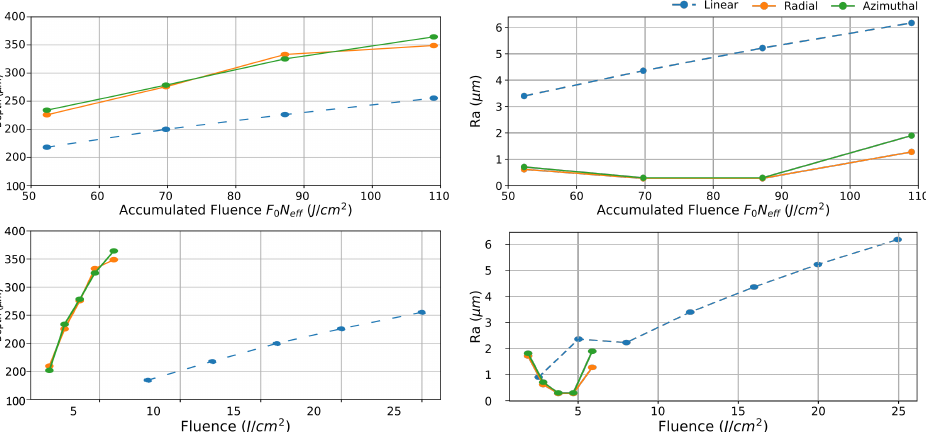
Figure 4. Depth ( right ) and arithmetic roughness ( left ) against accumulated fluence ( top ) and regular fluence ( bottom ) for linear Gaussian and CV in stainless-steel. CV produces significant lower roughness compared to the linear Gaussian case, being 16 times smaller at intermediate fluences. Besides, they produce deeper pattern by a factor two compared by Gaussian